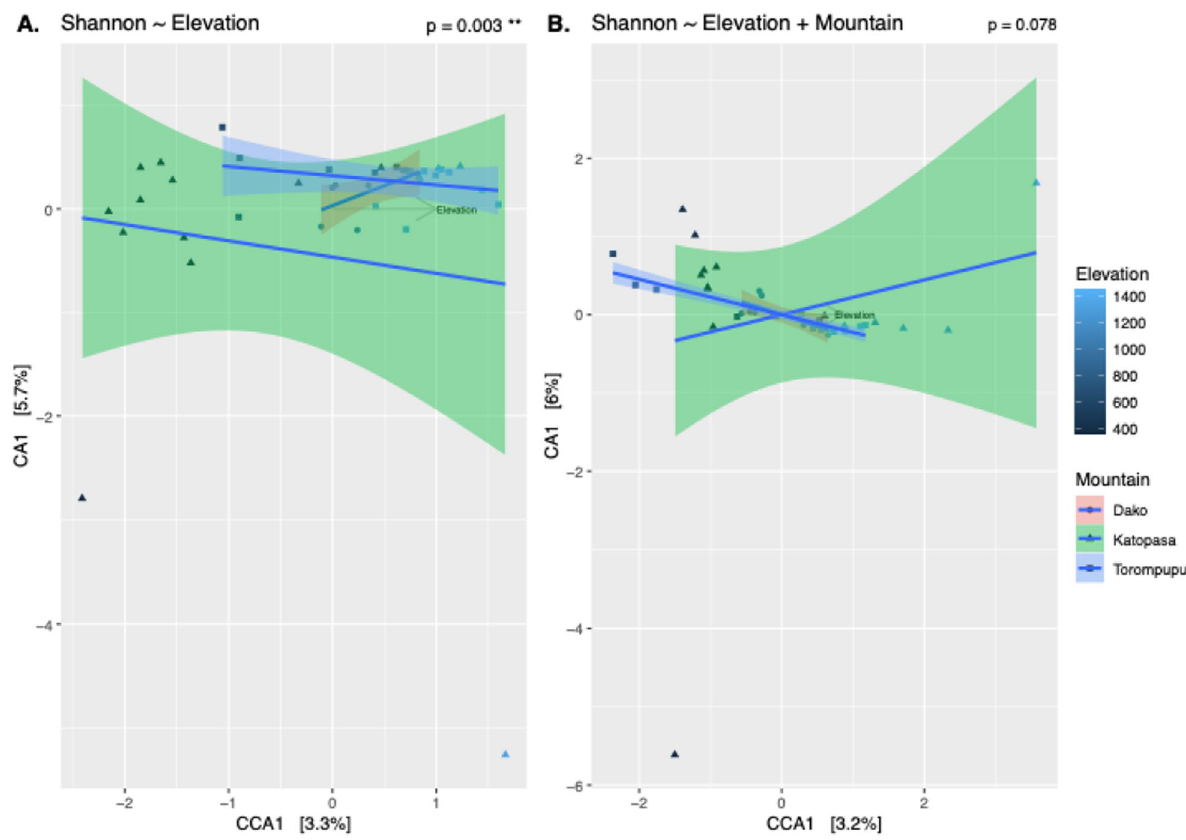
Fig. 5 Canonical Correspondence Analyses (CCAs) using only elevation as an environmental gradient ( A ) and with both elevation as a gradient and mountain as a conditional variable ( B ). Mountains are represented as separate regression lines, with shaded areas represent 95% confidence intervals. P values of each model indicates that the correlation between microbial diversity and elevation is less significant when sampling location is